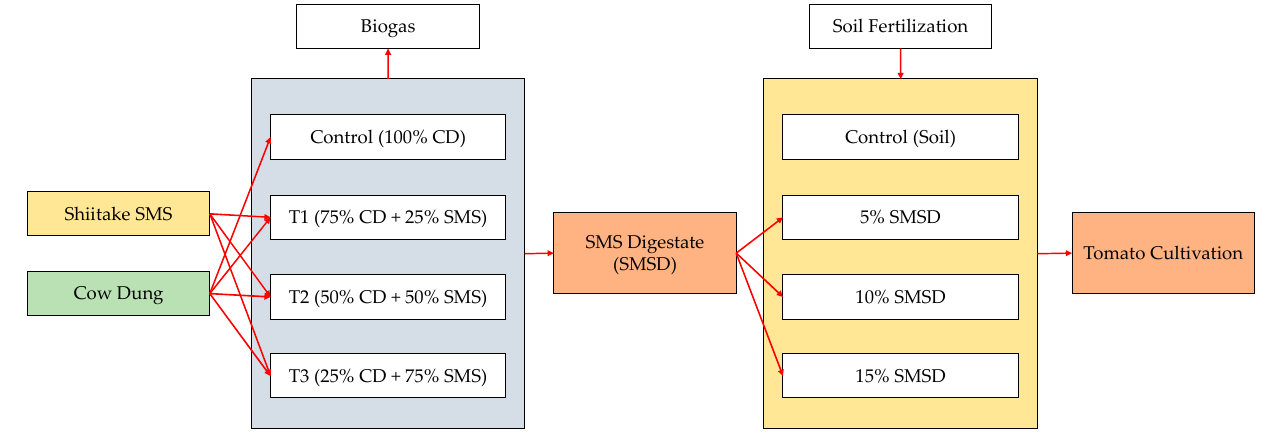
Figure 2. Experimental design for biogas production using SMS and soil fertilization using SMSD for tomato cultivation.